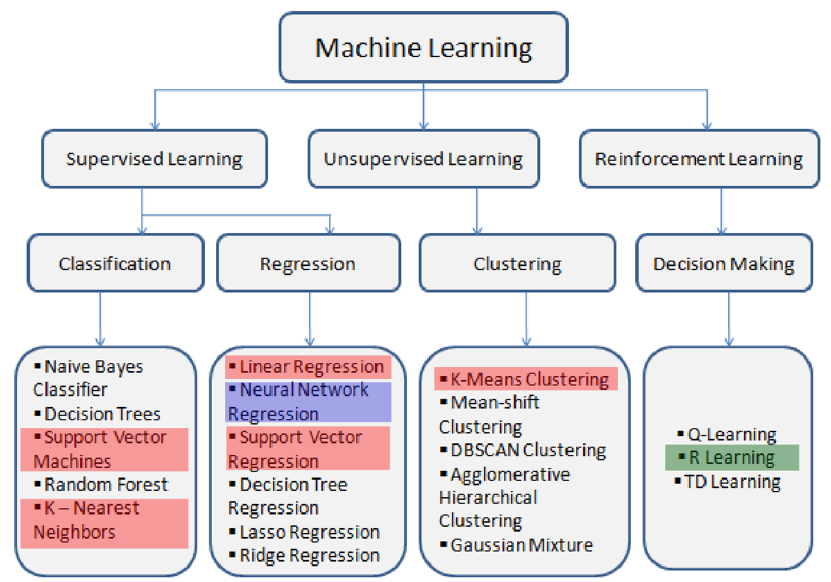
Figure 8. Analyzed algorithms (red); further research implementation (green); implemented along this paper (blue).